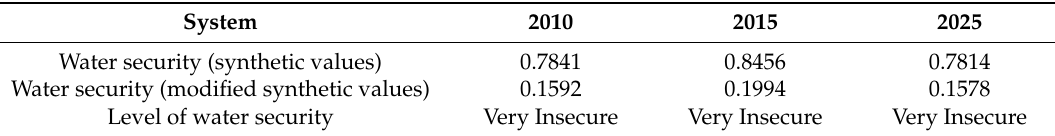
Table 5. Evaluation